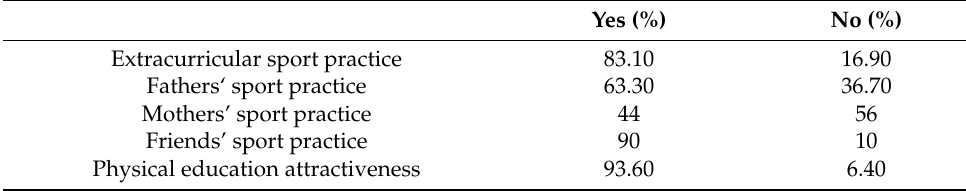
Table 1. Sample characteristics concerning sports